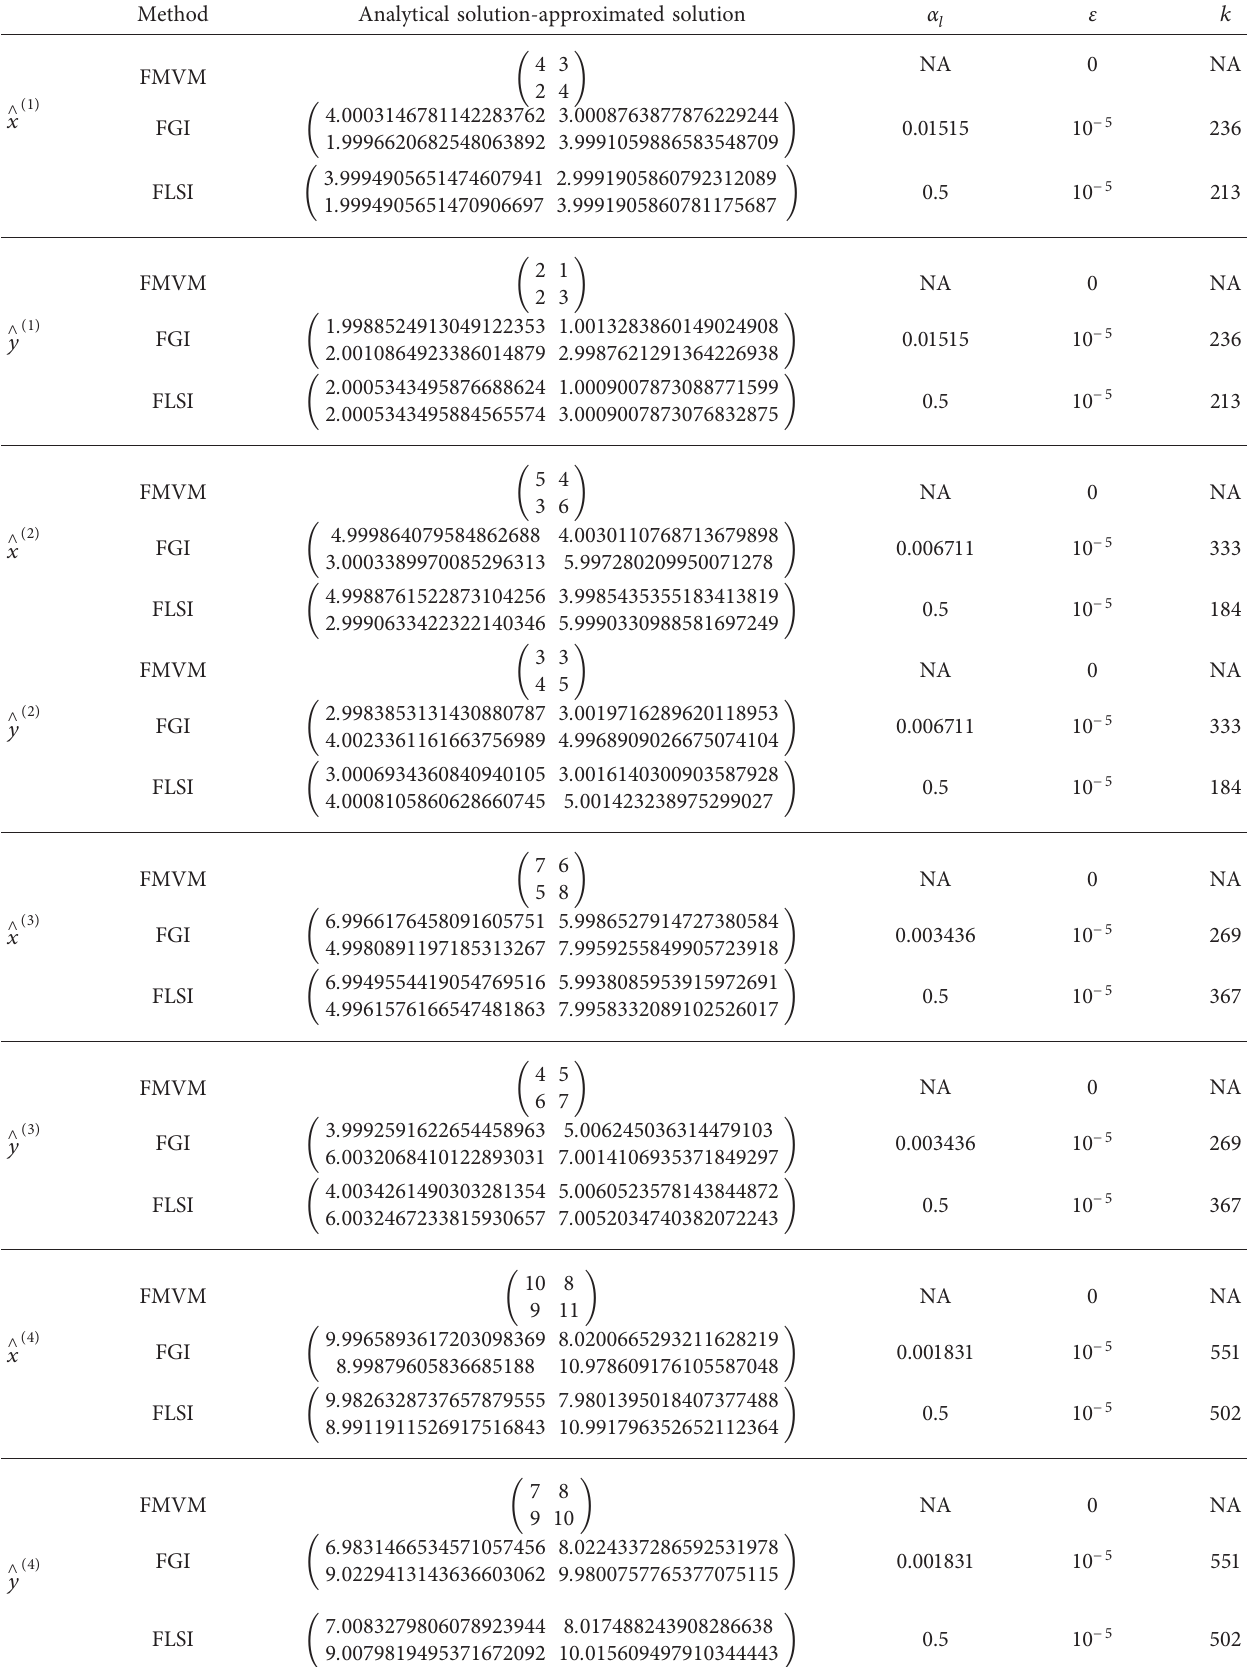
Table 1: Comparison between FFMVM, FGI, and FLSI for Example